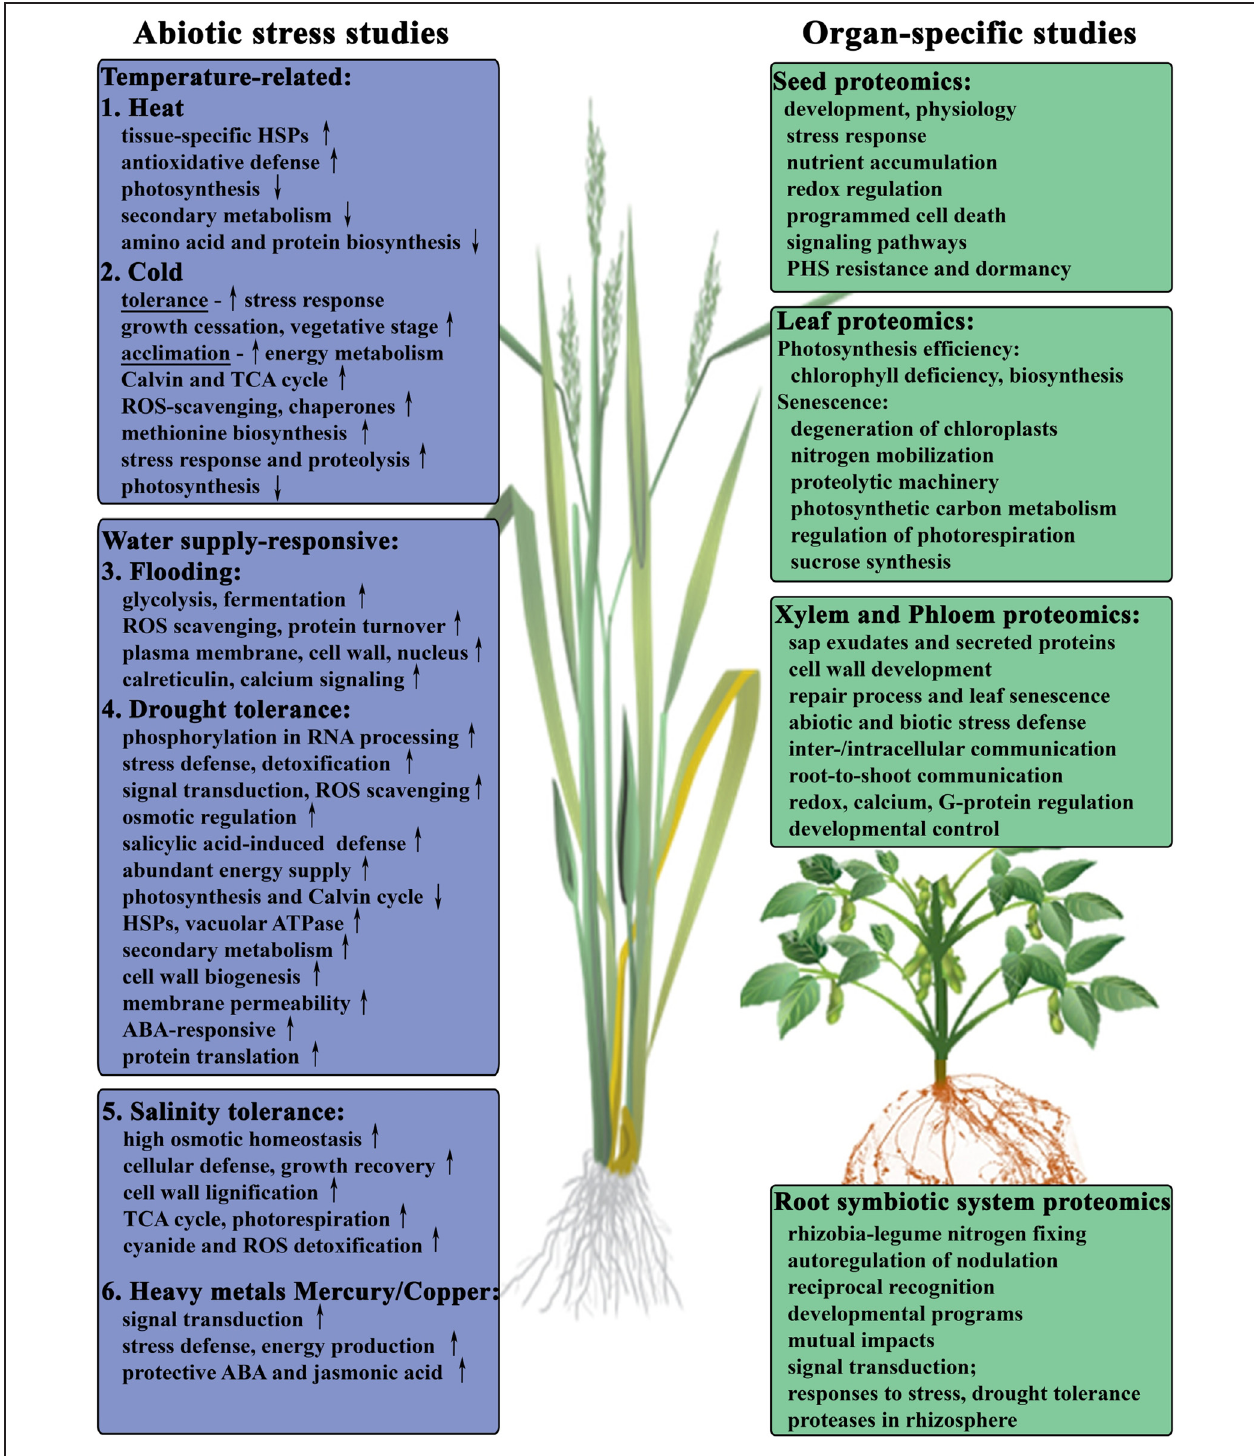
FIGURE 1 | Proteomic studies-driven insights into cellular activities during abiotic stress response of major crops. Summary of the abiotic stress studies published in: (1) Heat in soybean (Ahsan et al., 2010b). (2) Cold in winter wheat (Vítámvás et al., 2012; Kosová et al., 2013). (3) Flooding and anoxia in soybean seedlings (Nanjo et al., 2011 review; Komatsu et al., 2009, 2010; Yin et al., 2014). (4) Drought tolerance in